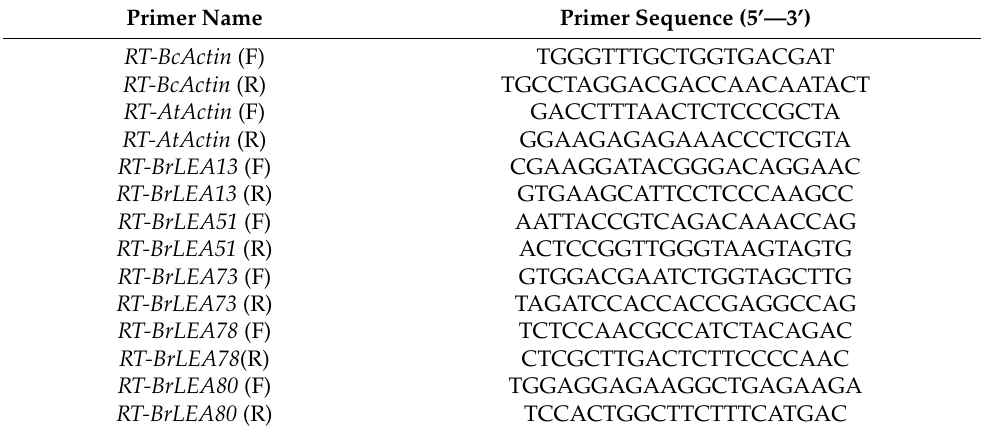
Table 1. BcLEA fluorescence quantitative primer sequence of